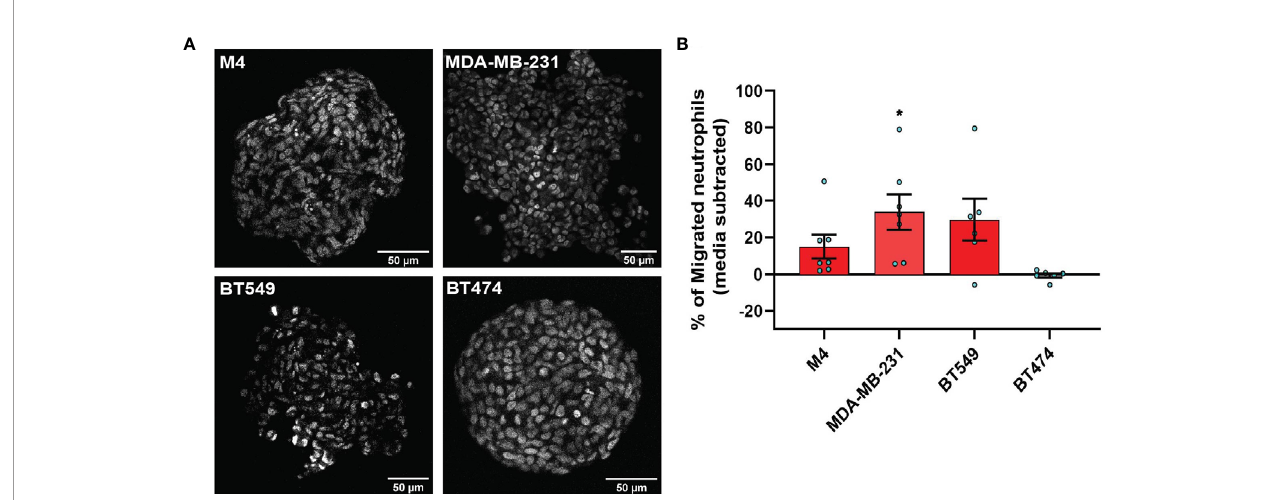
FIGURE 4 | TNBC spheroids secrete factors that induce neutrophil migration. (A) Representative 2-photon images of day-4 spheroids stained with the nuclear dye DRAQ5. Each image is from the fi eld of view located at the midpoint between the top and bottom of the z-stack imaging range. (B) Graph depicting the percentage of neutrophils that migrated into the bottom chamber of the transwells containing equal volume of TCM derived from M4, MDA-MB-231, BT549, or BT474 spheroids. Data shown are mean ± SEM from N=6-7 independent donors represented by individual dots. Each donor (N) represents an independent experiment. *P ≤ 0.05 when compared with BT474 TCM (one-way ANOVA with Dunnett ’ s multiple comparisons